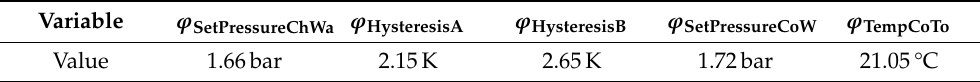
Table 4. For the interval request with an average value of 106.9kW, OptTopo provides the following values for the setpoint pressure at the chilled water, the hysteresis widths, the setpoint pressure at the cooling water, and the setpoint temperature at the cooling